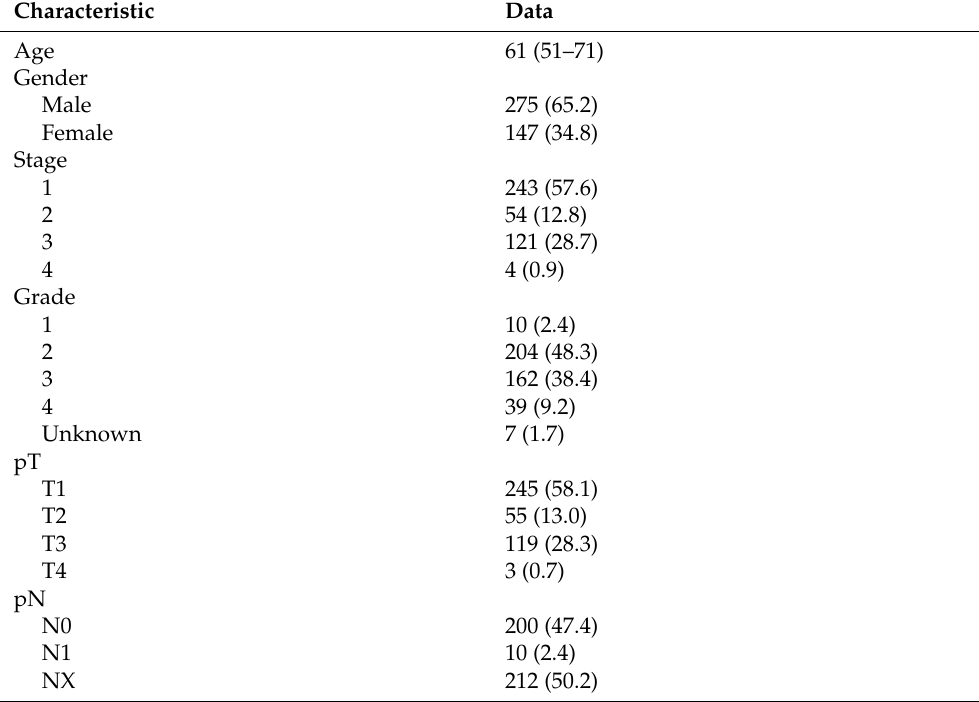
Table 1. Baseline clinicopathological characteristics of the TCGA non-metastasized ccRCC cohort ( n =